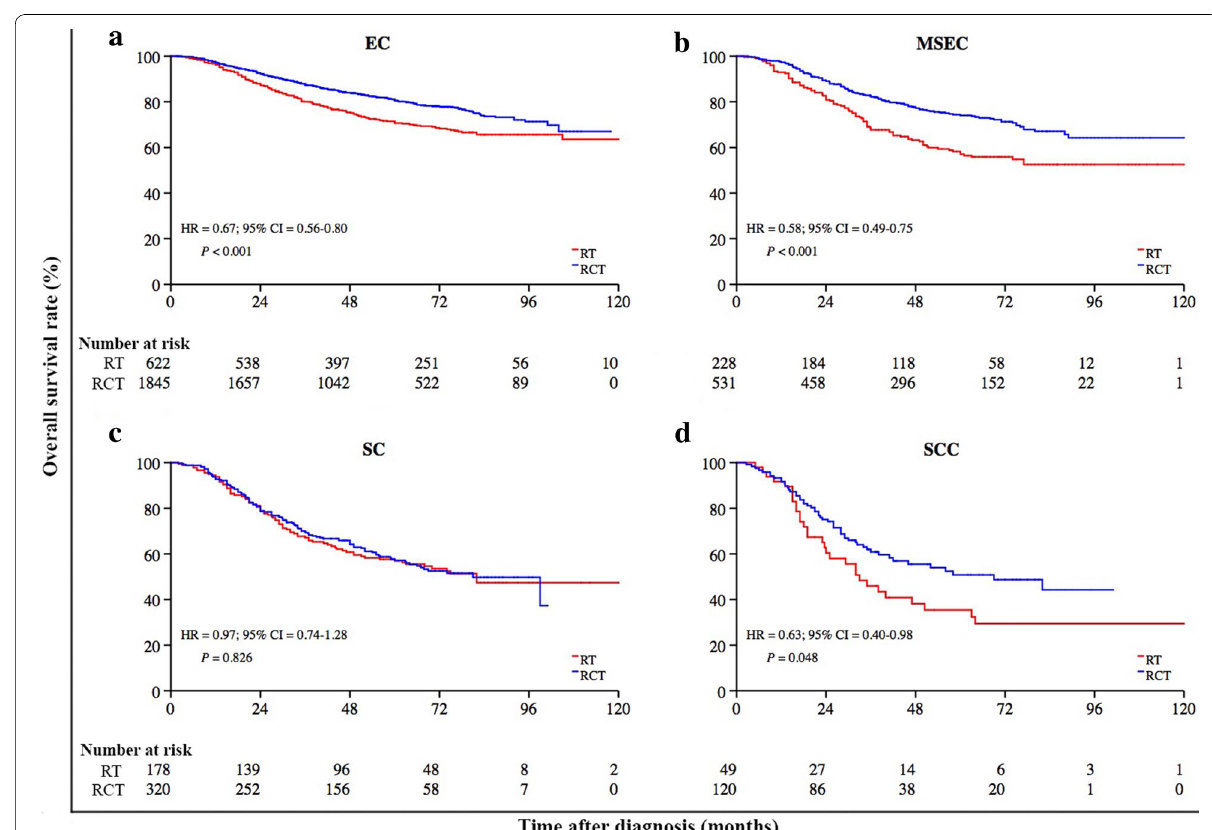
Fig. 9 Kaplan‑Meier survival estimates for the 3893 advanced NPC patients with different proposed subtypes who underwent radiochemotherapy (RCT) or radiotherapy (RT) alone. RCT significantly improved survival compared to RT alone for patients with EC ( P < 0.001, a ) and MSEC ( P < 0.001, b ), but not for patients with SC ( P 0.826, c ); this was also likely the case for those with SCC ( P 0.048, d ). The log‑rank test was used to compute P = = values. Hazard ratios (HRs) with 95% confidence intervals (CIs) were computed for each type (RCT versus RT